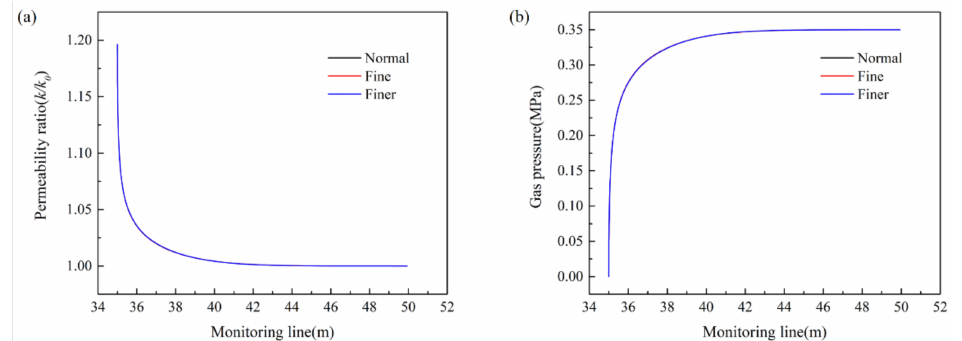
Figure 9. Permeability and gas pressure distribution curves of different mesh types at 10 d of drainage: ( a ) Permeability distribution curve. ( b ) Gas pressure distribution